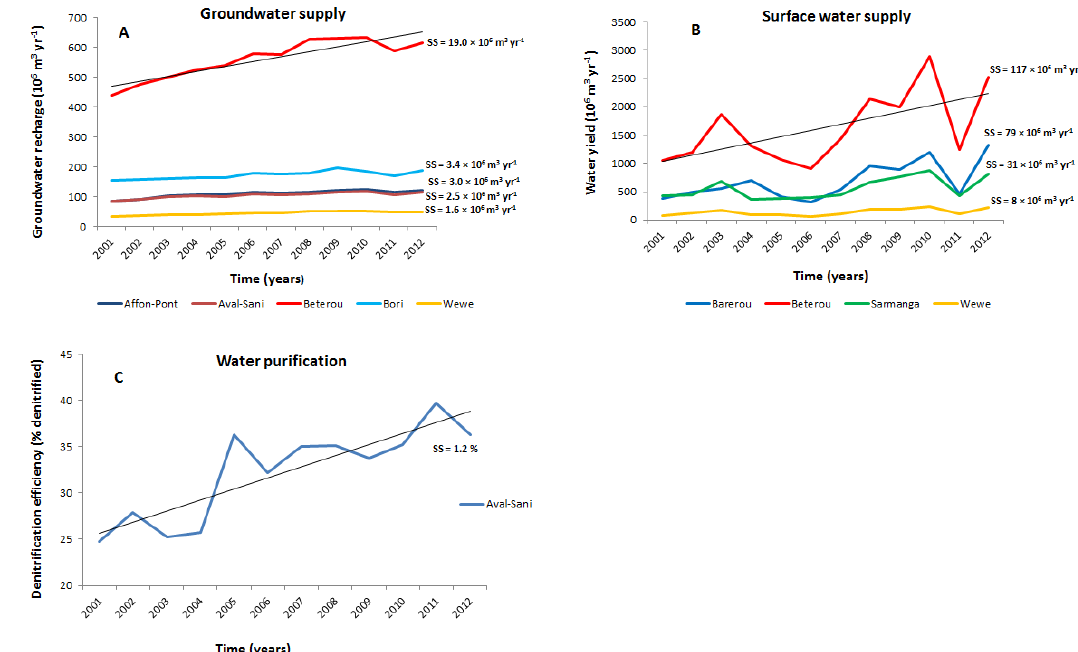
Figure 9. Trends in the service capacity of hydrological ecosystem services at the SEAU level in the Upper Ouémé watershed (SS is Sen’s slope estimator, which is a measure of the magnitude of change of a trend). For each graph, a single trend line is drawn solely to illustrate the direction of a